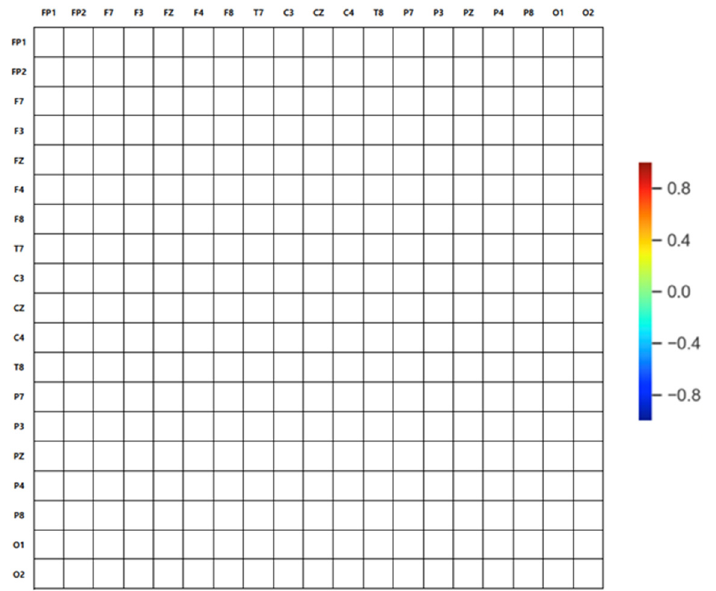
Figure 4. Deep-asymmetry matrix image map.